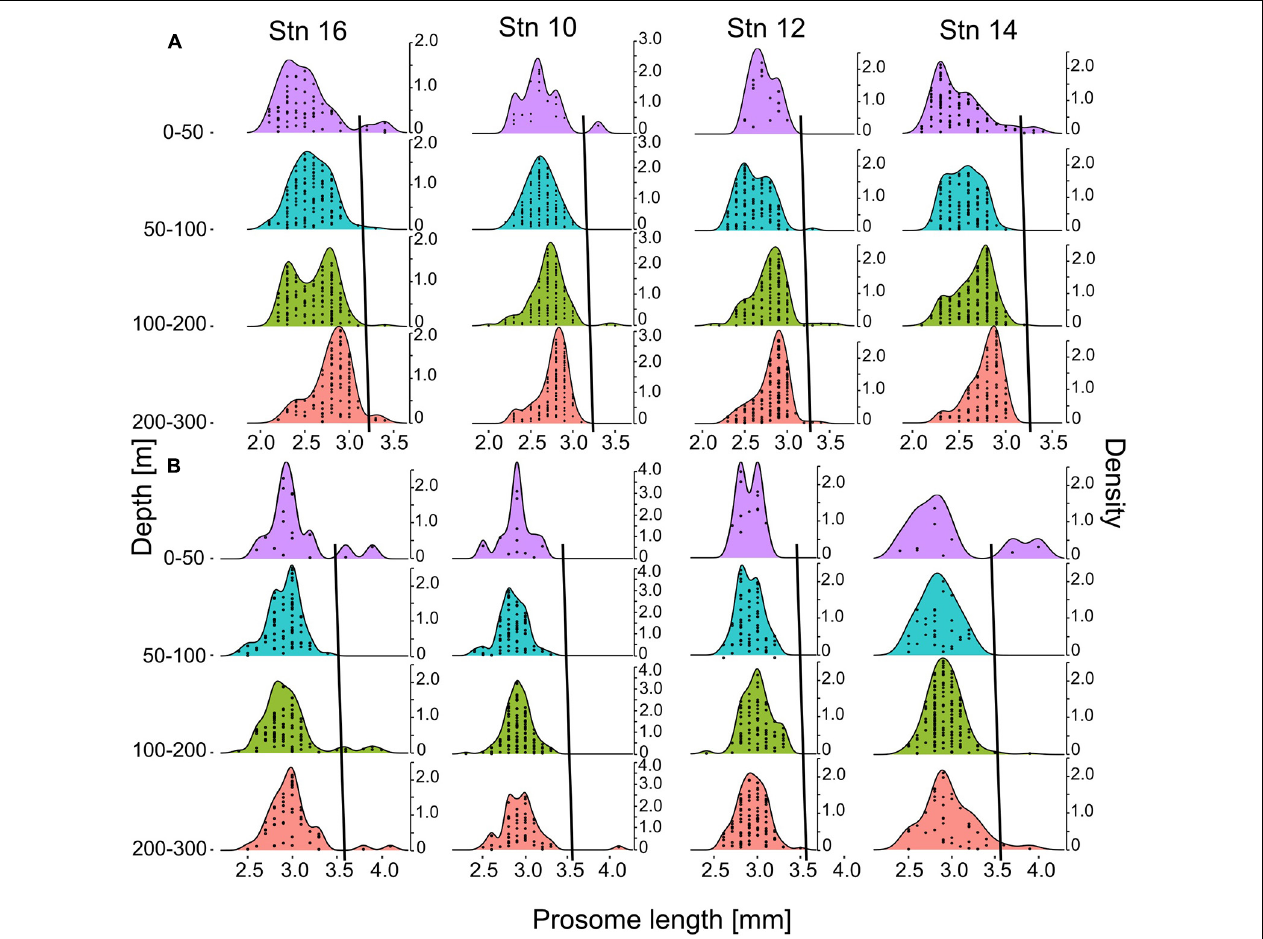
FIGURE 6 | Density plot of size distributions of C. finmarchicus / glacialis CV (A) and adult females (B) prosome lengths for four distinct depth intervals at stations 10, 12, 14, and 16. Sampling intervals 0–10 m and 10–50 m were pooled due to low numbers of individuals. Second y -axes indicate kernel density estimations. Stations are arranged in cross-frontal direction. Each dot within the size-frequency distribution indicates one individual per respective size. Black lines show the thresholds for species separation of C. finmarchicus and C. glacialis , i.e., smaller individuals to the left of the respective line were identified as C. finmarchicus , larger specimens to the right as C. glacialis